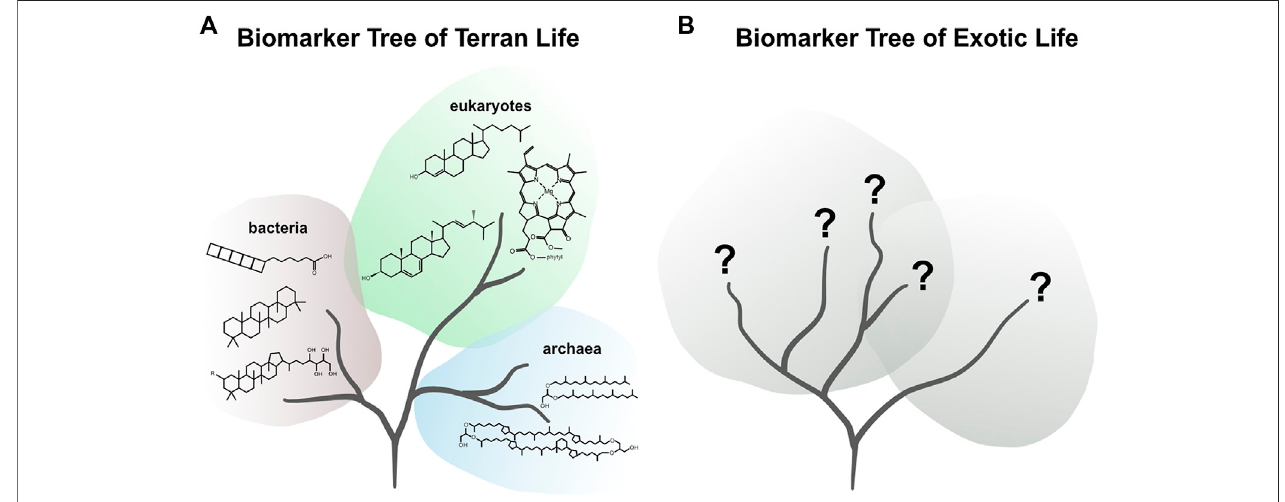
FIGURE 2 | (A) Figurative biomarker tree of Terran life representing the diversity of chemical biosignatures detectable via mass spectrometry. (B) Figurative biomarker tree of exotic life representing our lack of knowledge on the biochemical ancestry and thus potential chemical biosignatures of exotic life.